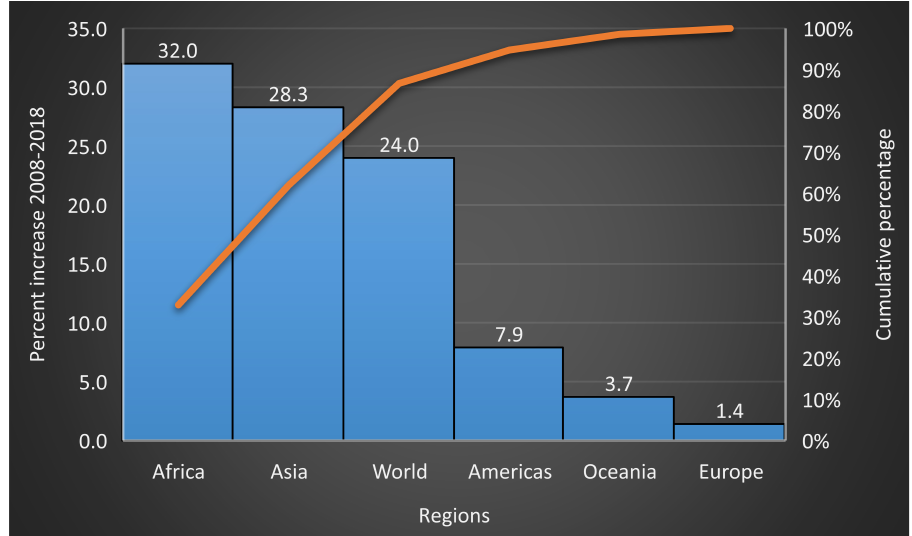
Figure 2. Percentage production increase of primary vegetables from 2008 to 2018 (calculated from production figures retrieved from Statistics Division of FAO). Available online: http://www.fao.org/faostat/en/#data/QC/ (accessed on 14 March 2020).